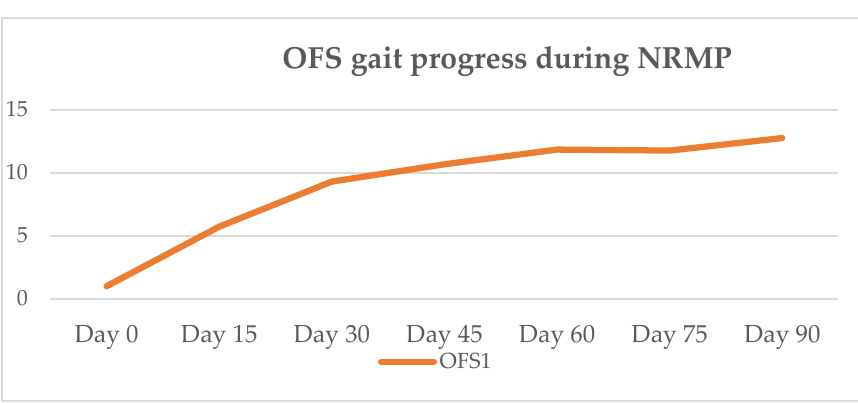
Table 5. OFS gait data records and mean time since admission and during outcomes (day 15, 30, 45, 60, 75, and 90), OFS at medical discharge and during follow-up (8–10-day, 1-month, and 6-month).